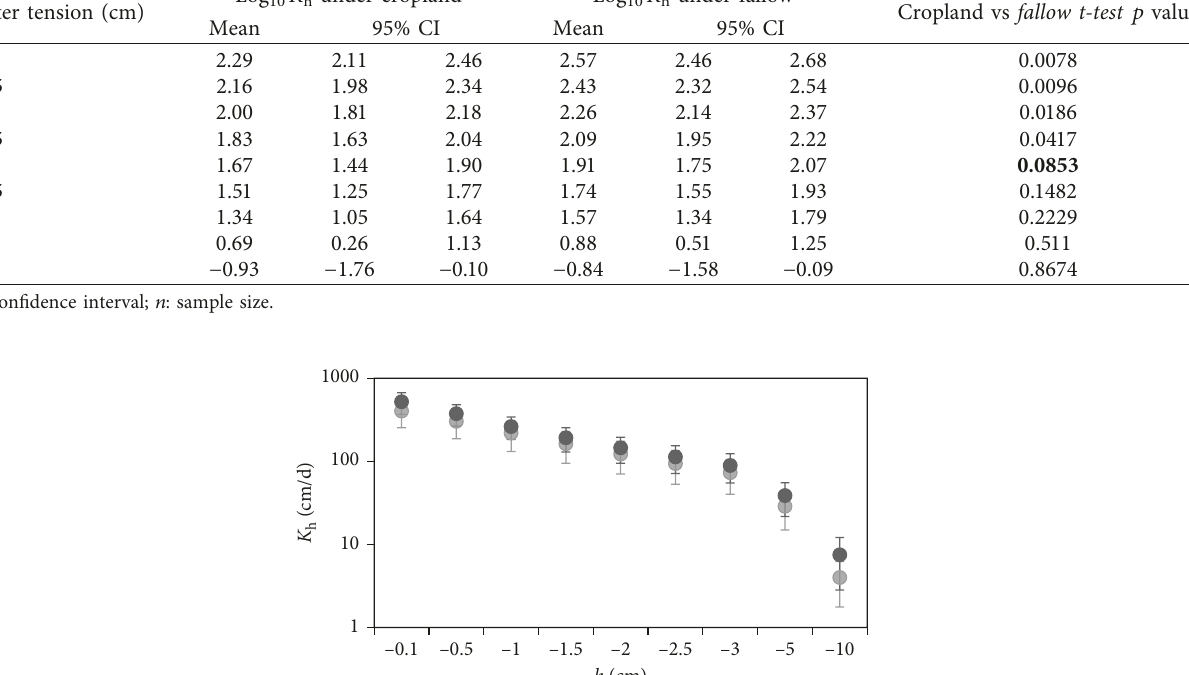
10 of unsaturated hydraulic conductivity with increasing water tension (